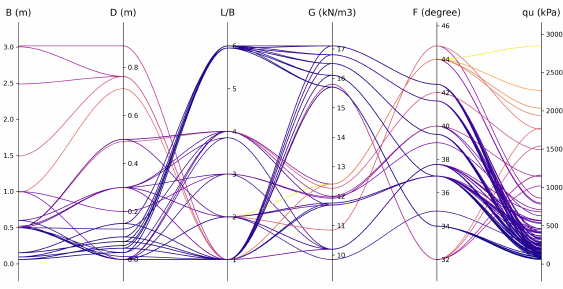
Fig. 4. Parallel coordinate plot for data set